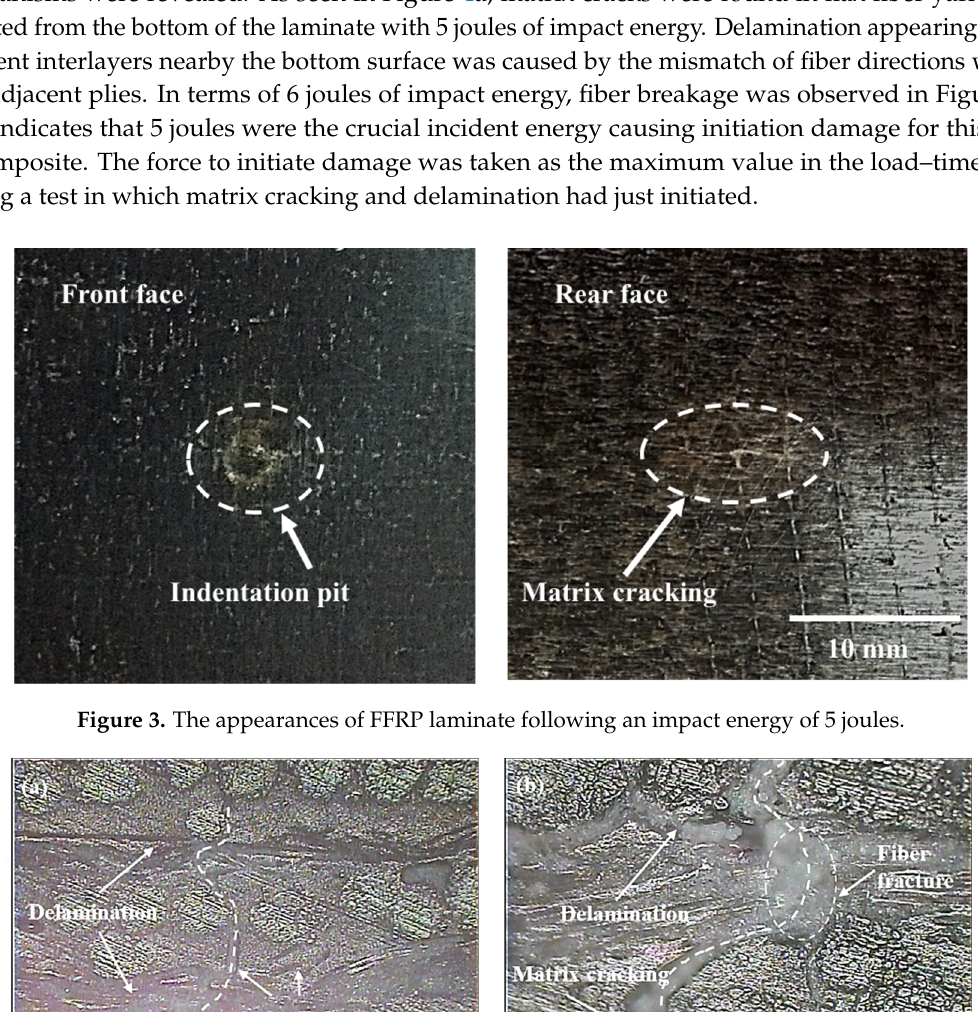
Figure 4. Micrographics of cross-sections for FFRP laminate subjected to ( a ) 5 joules and ( b ) 6 joules of impact energy.